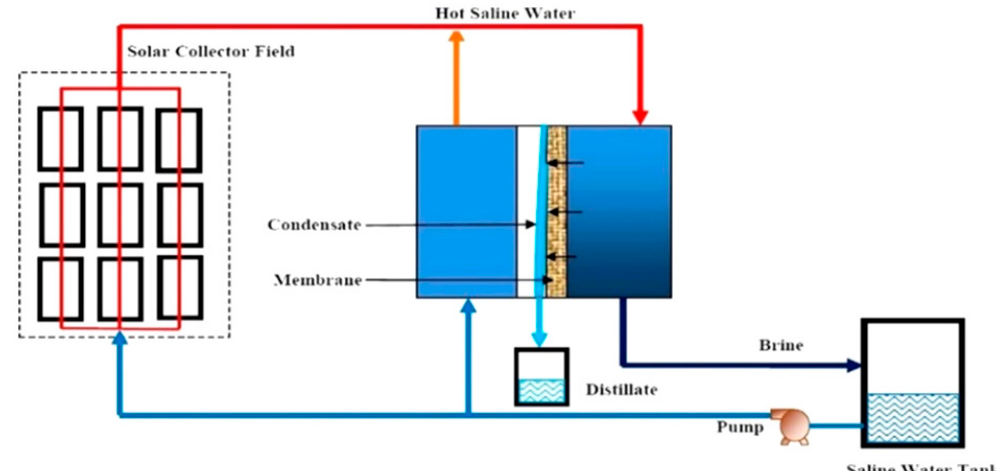
Figure 12. Solar powered membrane distillation [5]. Energies 2018 , 11 , x FOR PEER REVIEW